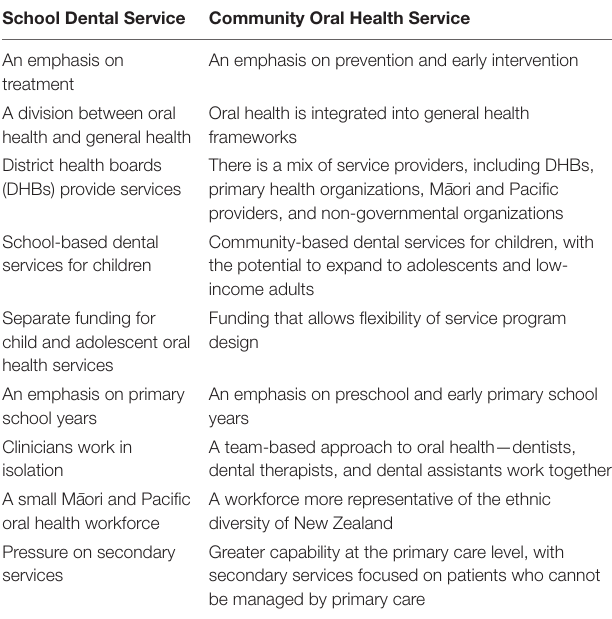
TABLe 3 | A comparison of oral health approaches [adapted from Ref.